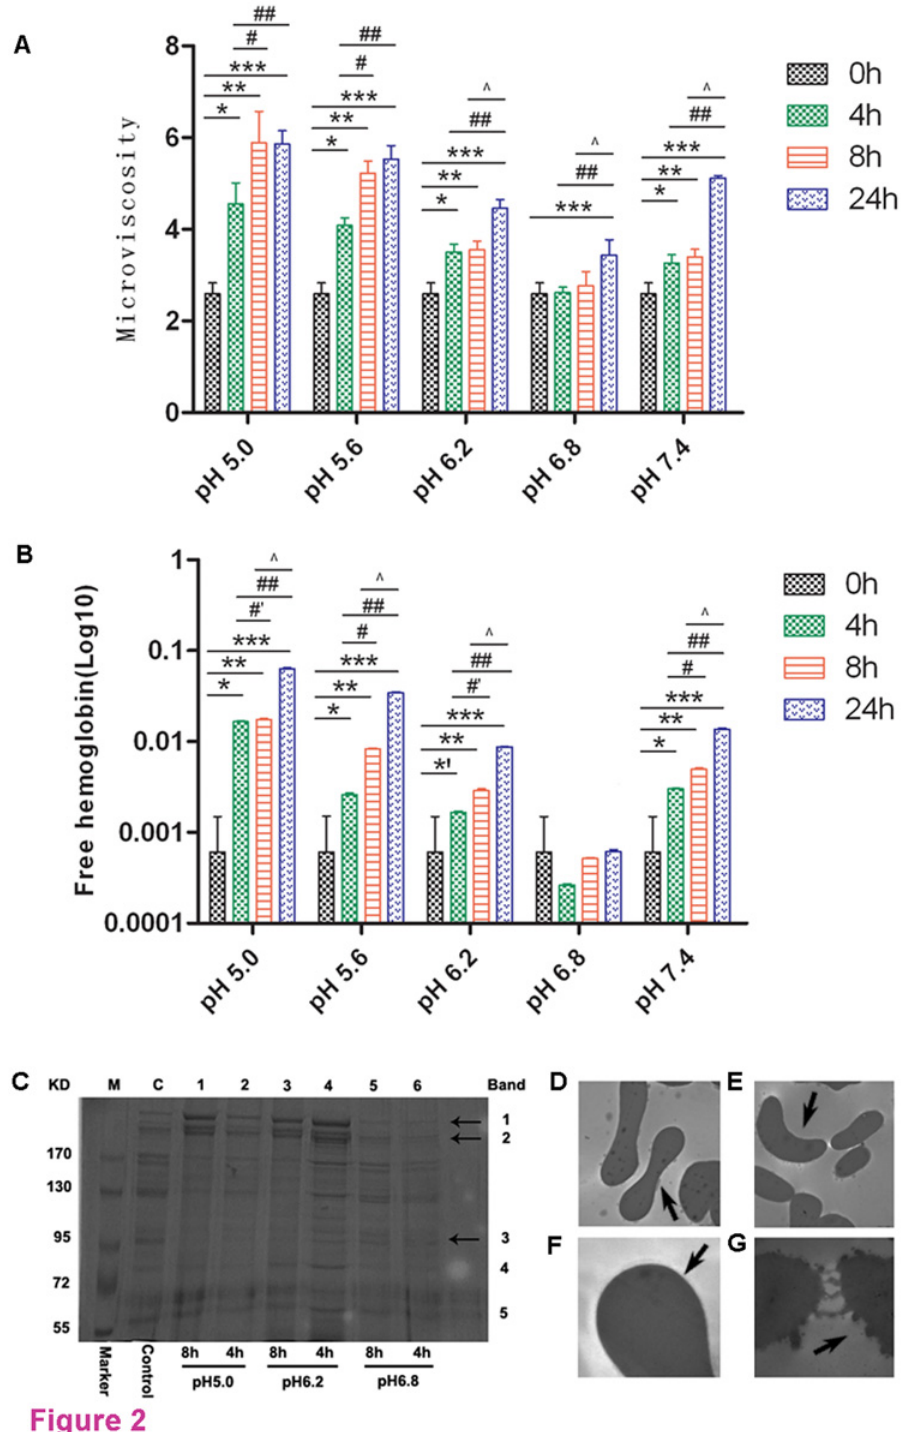
Fig 2. Effect of suspension pH and storage time on erythrocyte. A. Effect of the suspension of pH and storage time on microviscosity . * , p < 0.001, 0 h vs. 4 h; ** , p < 0.001, 0 h vs. 8 h; *** , p < 0.001, 0 h vs. 24 h; #, p < 0.001, 4 h vs. 8 h; ##, p < 0.001, 4 h vs. 24 h; ^, p < 0.001, 8 h vs. 24 h. B. Effect of the suspension of pH and storage time on free hemoglobin . * , p < 0.001, * 0 , p < 0.05, 0 h vs. 4 h; ** , p < 0.001, 0 h vs. 8 h; *** , p < 0.001, 0 h vs. 24 h; #, p < 0.001, # 0 , p < 0.05, 4 h vs. 8 h; ##, p < 0.001, 4 h